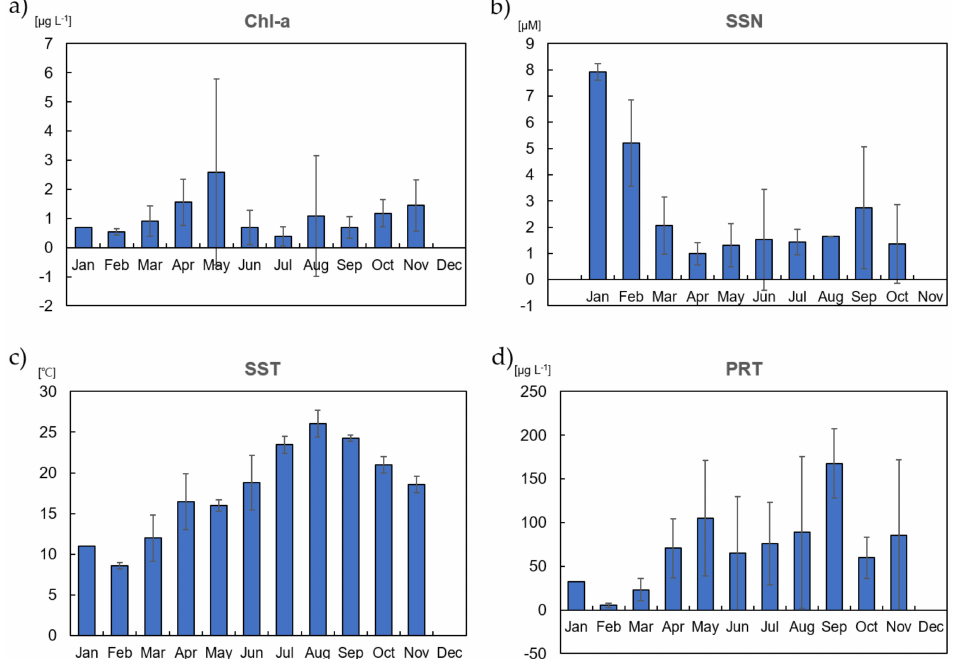
Figure 2. The monthly distribution of the field data, ( a ) is chlorophyll-a, ( b ) is sea surface nitrate, ( c ) is sea surface temperature, and ( d ) is protein concentration of